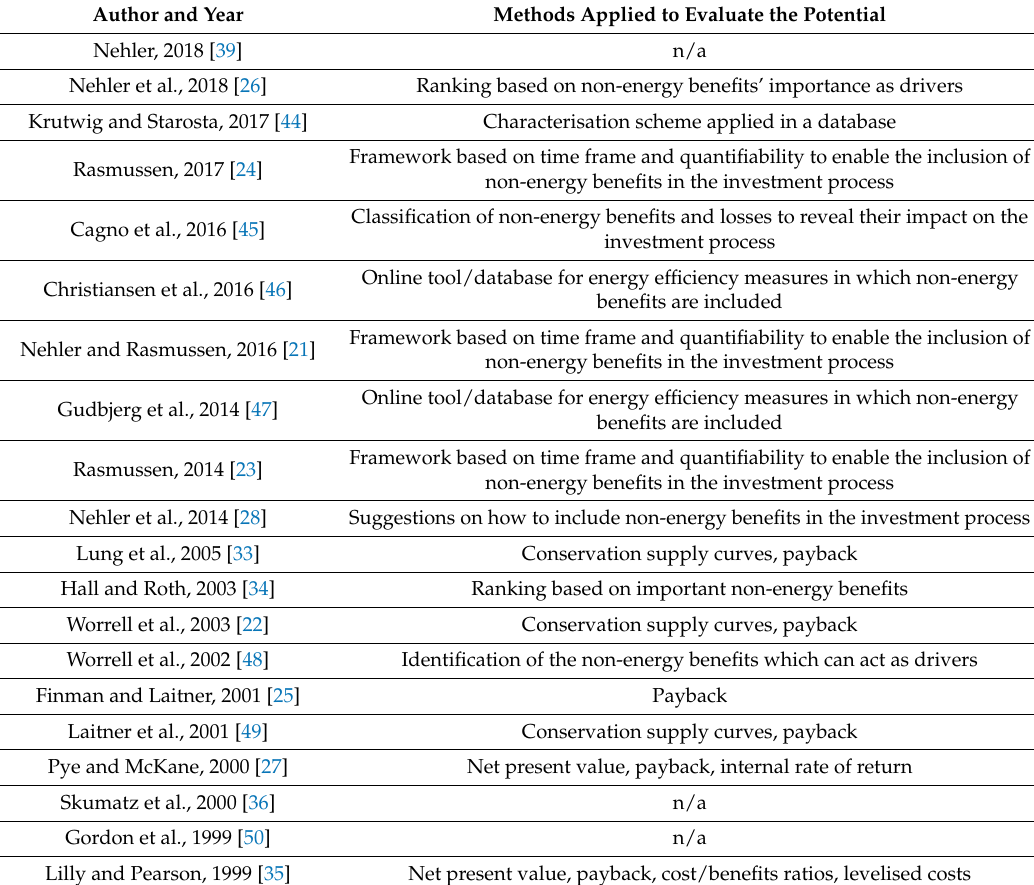
Table 6. Methods applied to evaluate the potential of non-energy benefits in the reviewed publications in the area of non-energy benefits in industry. n/a—not